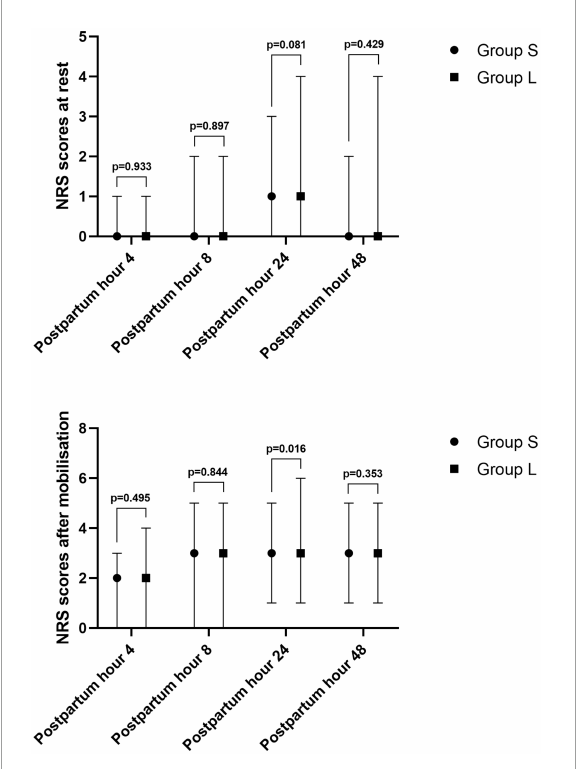
FIGURE2 Post-operative pain scores (NRS) at rest and after mobilization in patients.